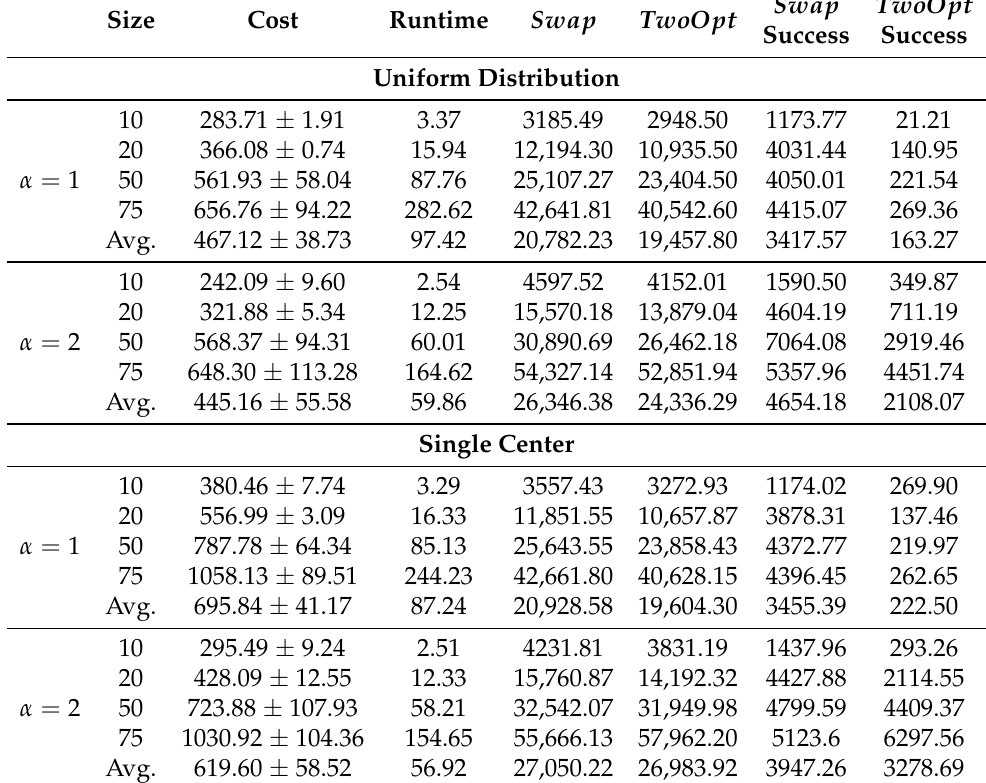
Table 3. Results obtained with the proposed GRASP approach, SA